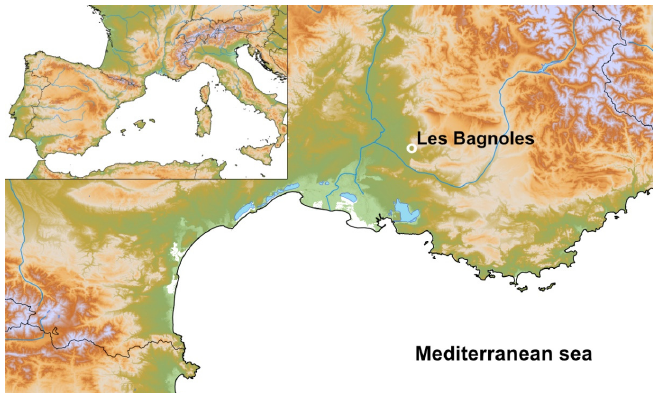
Department, SE France. (Software: QGIS3.6, © European Union, Copernicus Land Monitoring Service (2016), European Environment Agency (EEA)).